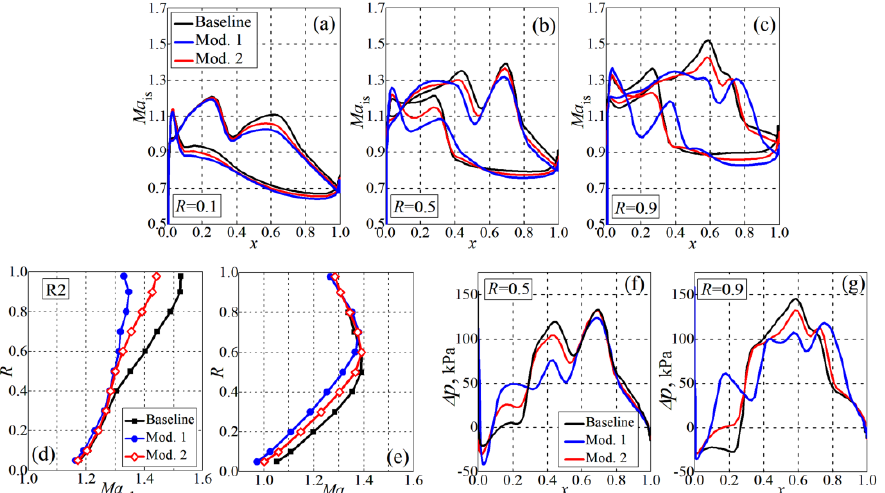
Figure 8. Rotor 2 surface isentropic Mach number of baseline, Mod.1 and Mod.2 ( a – c ); shock Mach number ( d , e ) and blade aerodynamic load distribution ∆ p ( f , g ), design point.